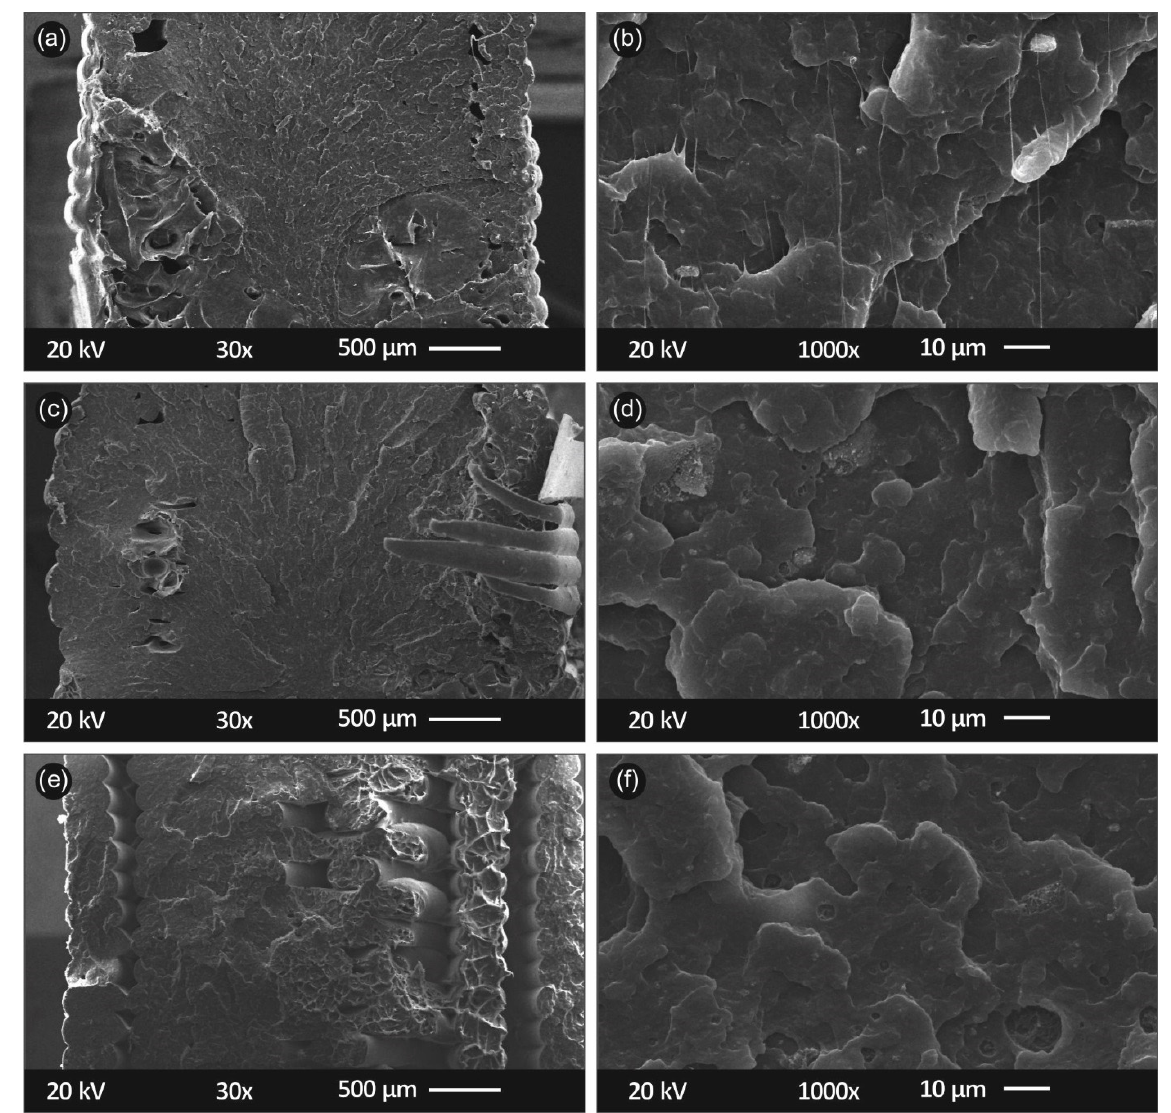
Figure 9. SEM images of the tensile specimens’ fractured areas: ( a ) ×30 magnification of PP/SiO 2 0.5 wt.%; ( b ) ×1000 magnification of PP/SiO 2 0.5 wt.%; ( c ) ×30 magnification of PP/SiO 2 2.0 wt.%; ( d ) ×1000 magnification of PP/SiO 2 2.0 wt.%; ( e ) × 30 magnification of PP/SiO 2 4.0 wt.%; ( f ) × 1000 mag nification of PP/SiO 2 4.0 wt.%.